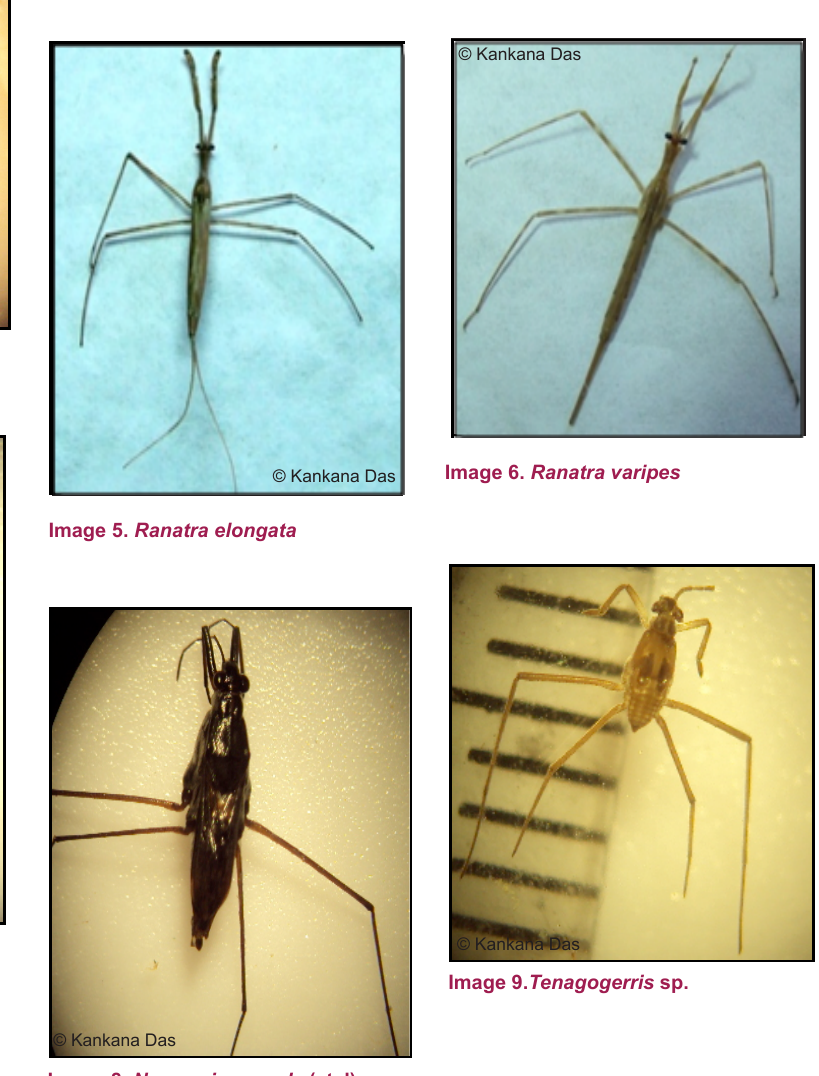
Image 8. Neogerris parvula (stal)